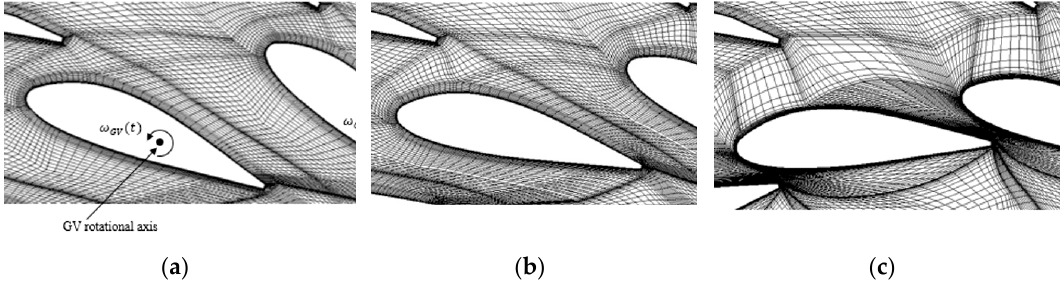
Figure 4. Guide vanes (GVs) meshes at different time instants during a closure. ( a ) t d = 0 s; ( b ) t d = 1 s; ( c ) t d = 2.5 s.